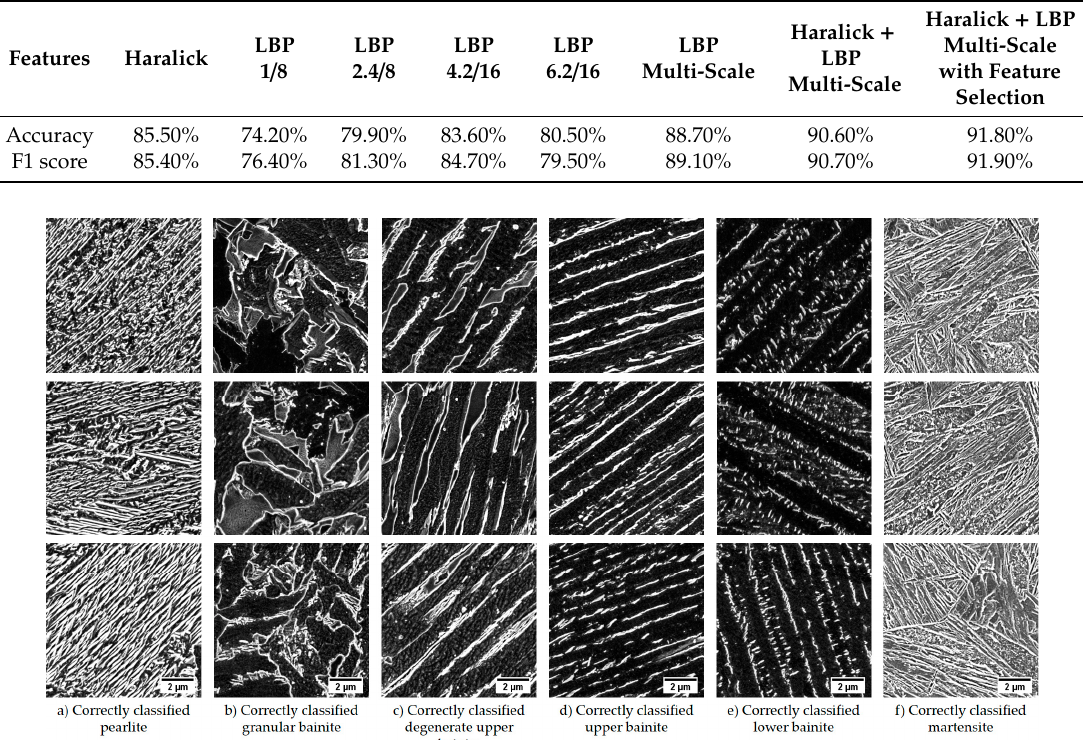
Table 8. Overview of classification results for the di ff erent features that were used to classify.